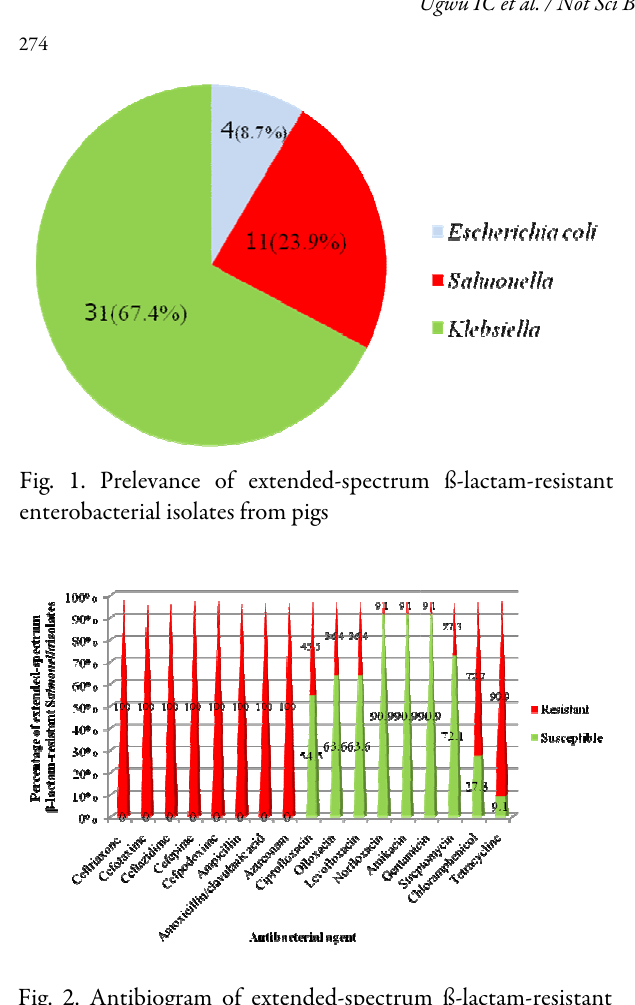
Fig. 2. Antibiogram of extended-spectrum ß isolates from pigs